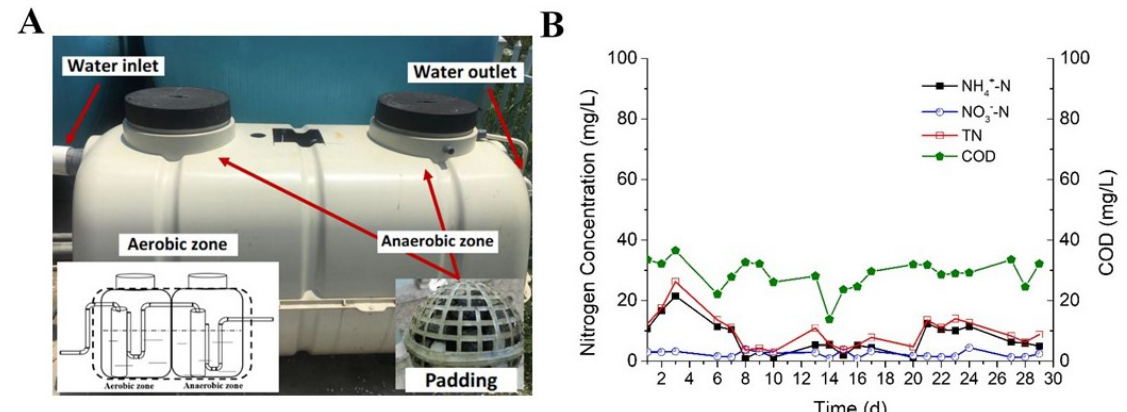
Figure 6. Characterization of strain F19 in a culturing and purification platform with low-C / N domestic wastewater. ( A ) Nitrogen removal purification tank. ( B ) Profile of nitrogen concentration during domestic sewage treatment with strain